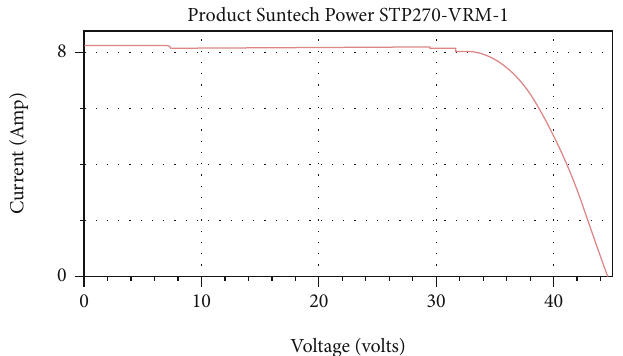
Figure 16: I ‐ V characteristics of Suntech Power PV module. Table 6: Performance indicators of the PV park from Grojdibodu. Performance indicators (in the fi rst